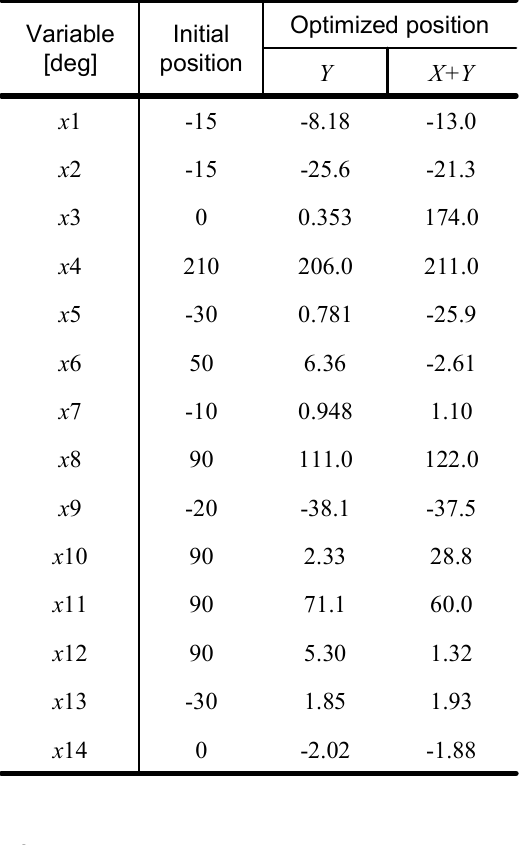
Initial and optimized variables